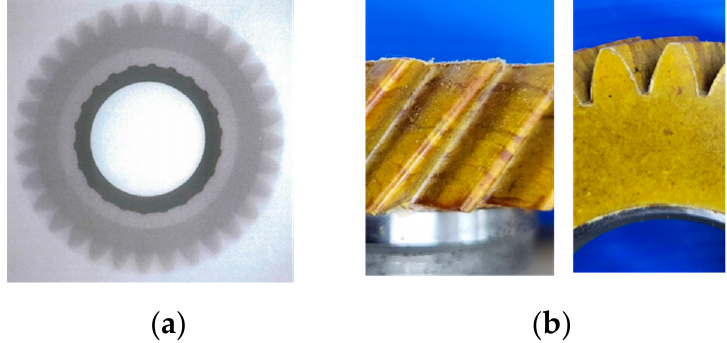
Figure 15. ( a ) Internal X-ray CT image; ( b ) Visual inspection of the external surface. The results obtained from gear measurement equipment (KLINGELNBERG P26) are shown in Figure 16. The measurement of the dimensions of the WLF helical gear revealed that the single pitch error at left and right flanks were 10.1 µ m and 11.2 µ m, respectively, and the runout error was 11.6 µ m. This satisfies a single pitch error standard of 14 µ m or less and a runout error standard of 39 µ m or less for existing steel helical gears.